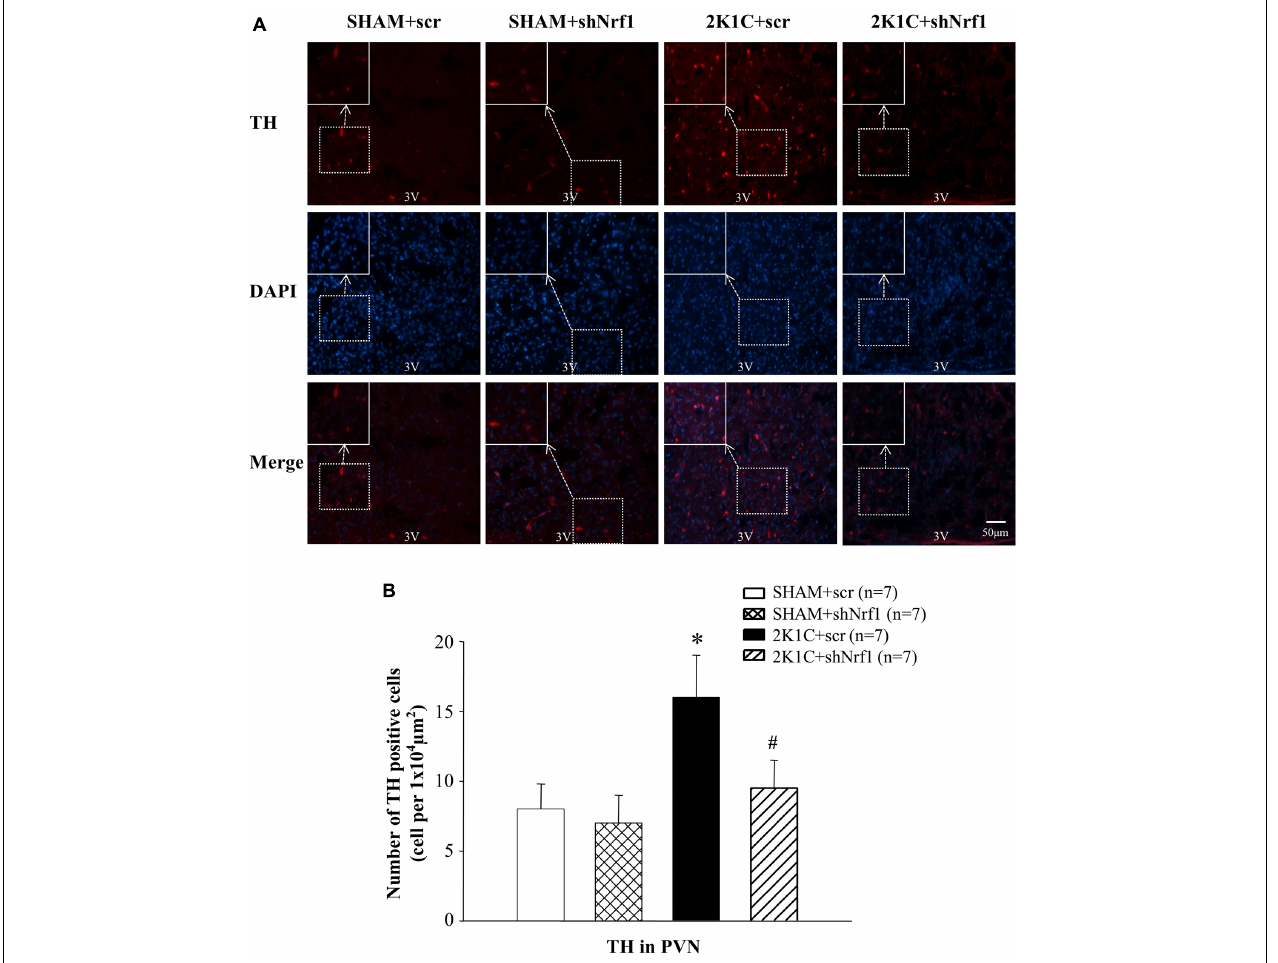
FIGURE 5 | Effects of knocking down of Nrf1 on TH expression in PVN of hypertensive rats. (A) Immunofluorescence for the expression of TH in PVN in different groups. (B) Changes of number of TH positive cells in PVN. ∗ P < 0.05 vs. control animals (SHAM + scr or SHAM + shNrf1). # P < 0.05 2K1C + shNrf1 vs. 2K1C +